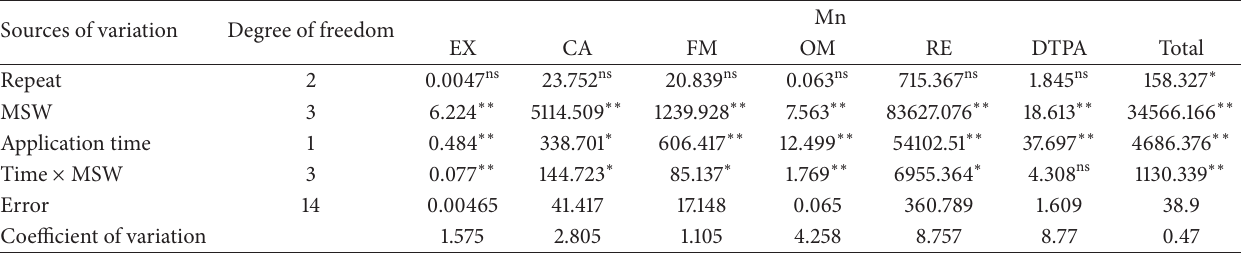
Table 2: Analysis of variance and mean square values of total manganese, DTPA, and various components of municipal solid waste compost in two years.